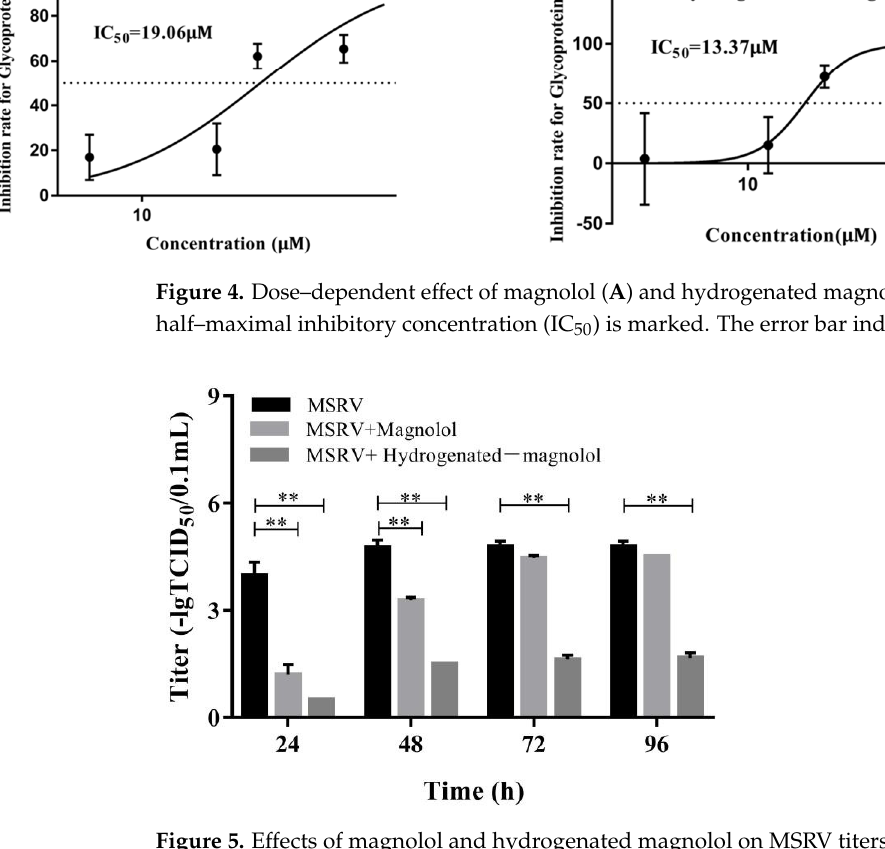
Figure 5. Effects of magnolol and hydrogenated magnolol on MSRV titers. GCO cells infected with MSRV were treated with or without magnolol/hydrogenated magnolol (28.89 µ M), and viral titers were calculated using the Karber method at the indicated times. The error bar indicates the SEM. ** p < 0.01.